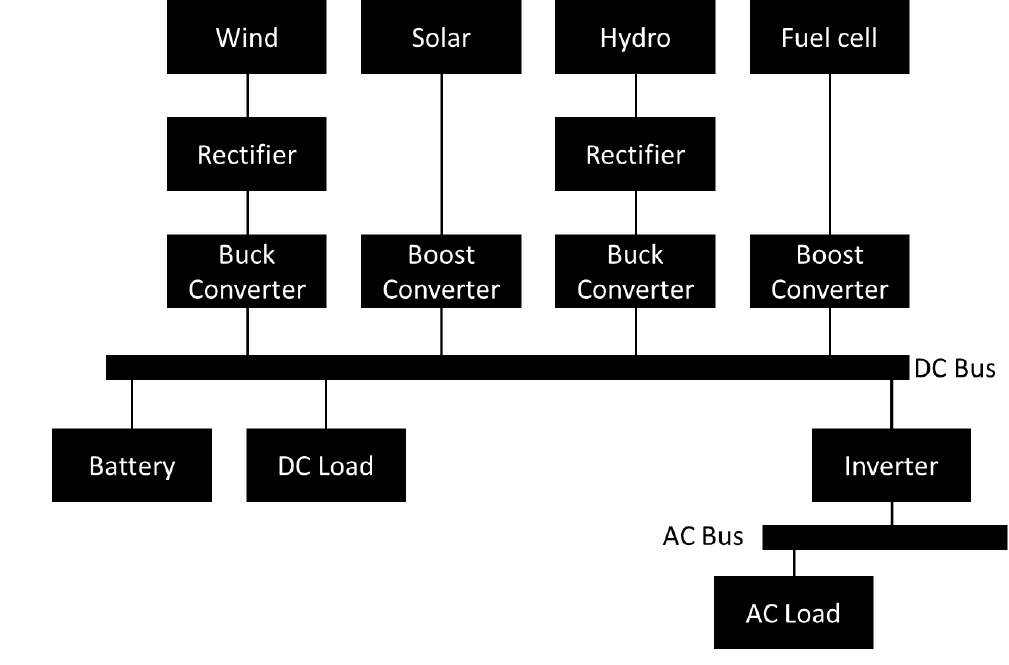
Figure 7. Energy flow in the test bench over the DC bus.